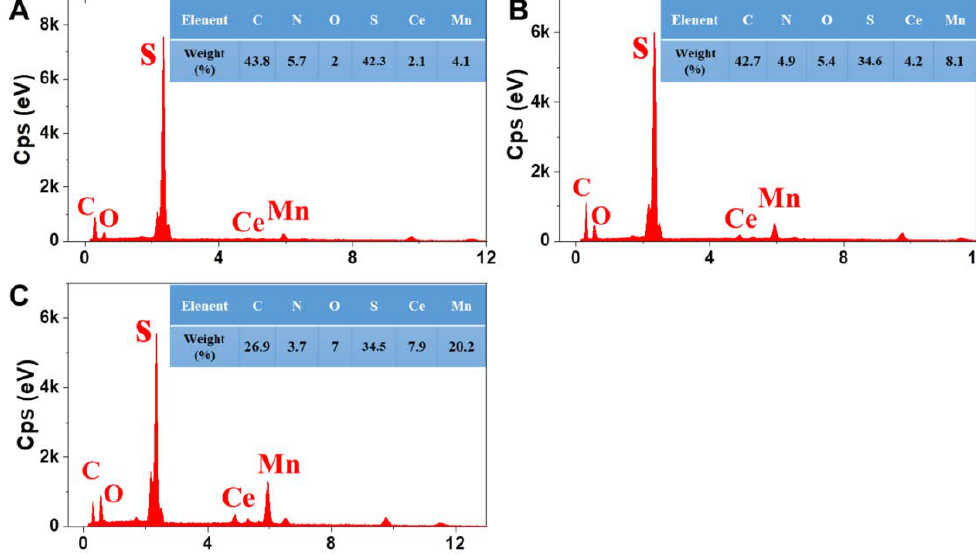
Figure 5. EDS (X-Max Energy-Dispersive X-ray spectrometer) images of the three different Mn/Ce oxides decorated PPS NPFF: ( A ) PPS NPFF / Mn / Ce-C; ( B ) PPS NPFF / Mn / Ce-D; ( C ) PPS NPFF / Mn / oxides decorated PPS NPFF: ( A ) PPS NPFF/Mn/Ce-C; ( B ) PPS NPFF/Mn/Ce-D; ( C ) PPS NPFF/Mn/Ce- P.